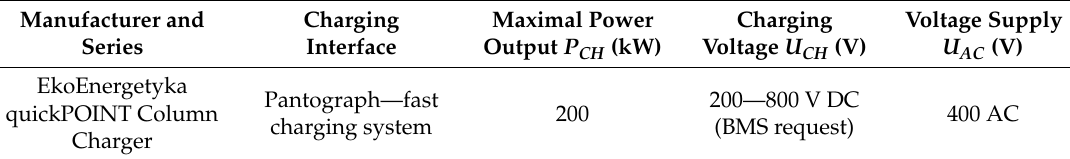
Table 2. Technical parameters of the charging point at Sparta´nska Street [21].